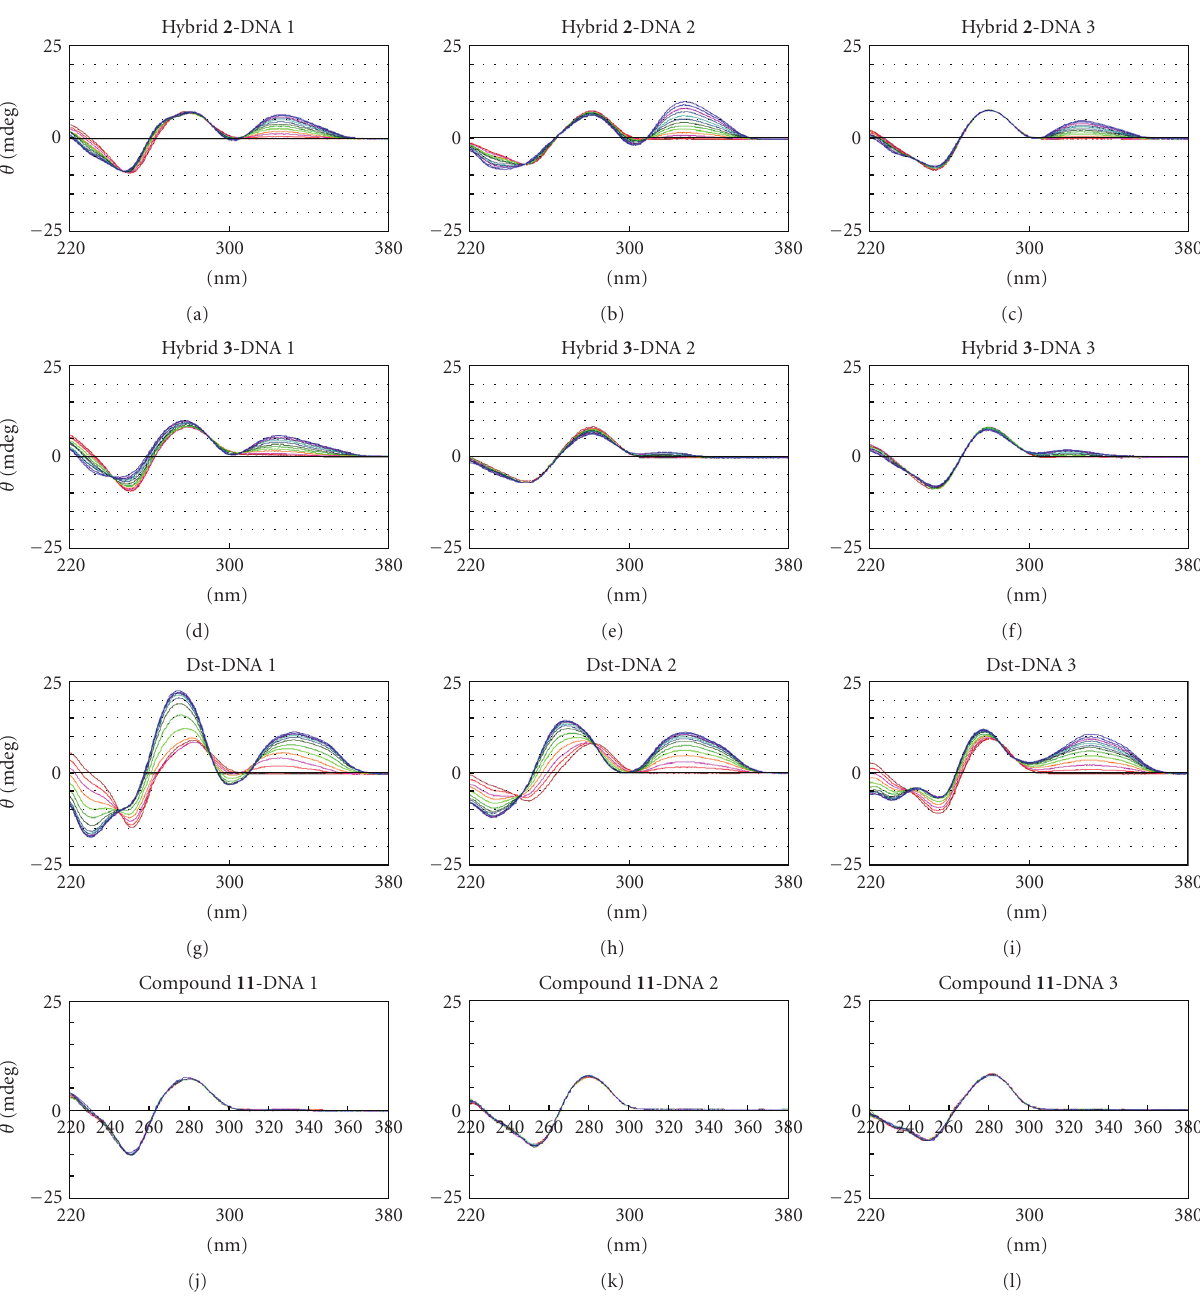
Figure 2: CD spectra for the DNA duplexs with ligand (Hybrid 2 , Hybrid 3 , Dst, or compound 11 ) at several [Iigand]/[duplex] ratios in bu ff er consisting of 10 mM sodium phosphate, 10 mM NaCL, and 0.1 mM Na 2 EDTA at pH 7.0 and 20 ◦ C: 3.0mL of duplex solution (5.8 μ M) titrated ligand (Hybrid 2, Hybrid 3 , and Dst: 0–14.5 μ M) and 3.0 mL of duplex solution (4 μ M) titrated ligand (compound 11 : 0–12 μ M). ∗ DNA duplexs: DNA 1 = d-(5 (cid:2) -CGC AAATT GGC-3 (cid:2) )-d-(3 (cid:2) -GCG TTTAA CCG-5 (cid:2) ), DNA 2 = d-(5 (cid:2) -CGC AGACT GGC-3 (cid:2) )-d-(3 (cid:2)